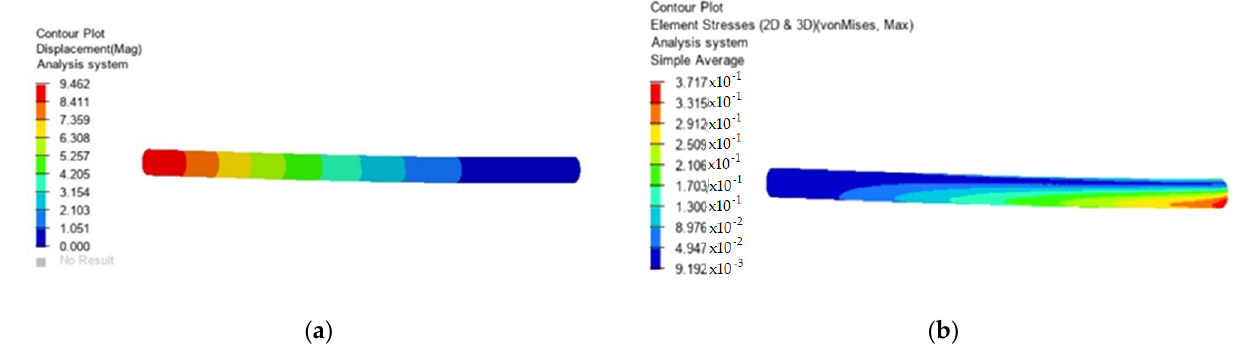
Figure 2. Material with voids (2%). ( a ) Displacement (mm); ( b ) stress